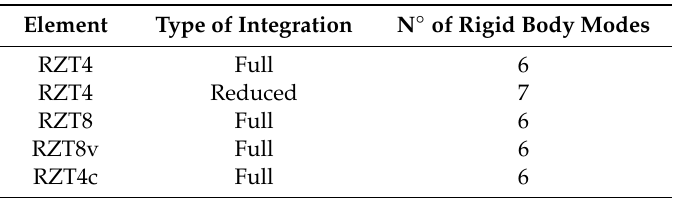
Table 7. Number of rigid-body modes.